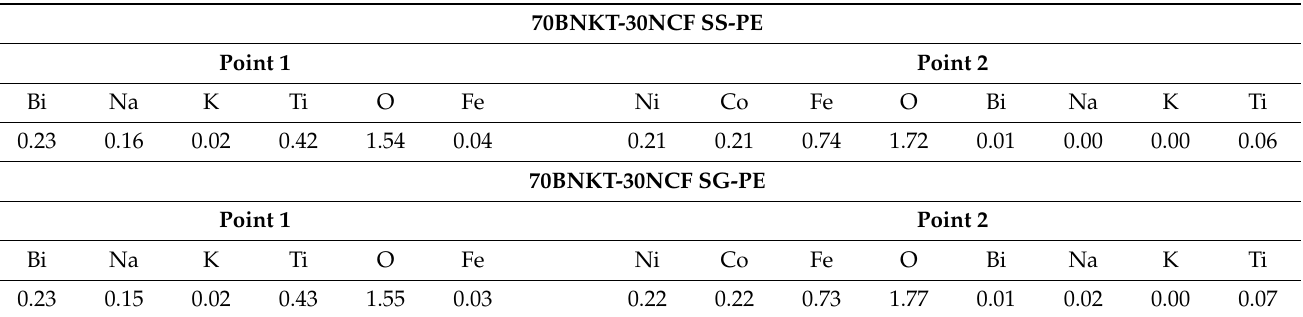
Table 2. Atomic content determined by EDS of the 70BNKT-30NCF SS-PE and SG-PE